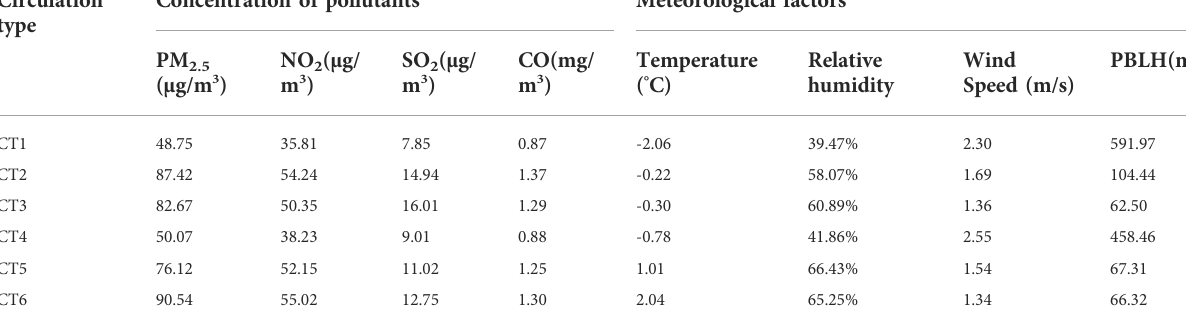
TABLE 1 The average concentrations of four major pollutants (PM 2.5 , NO 2 , SO 2 , and CO) as well as the average values of temperature, humidity, wind speed, and boundary layer height under the six circulation patterns from 2014 to